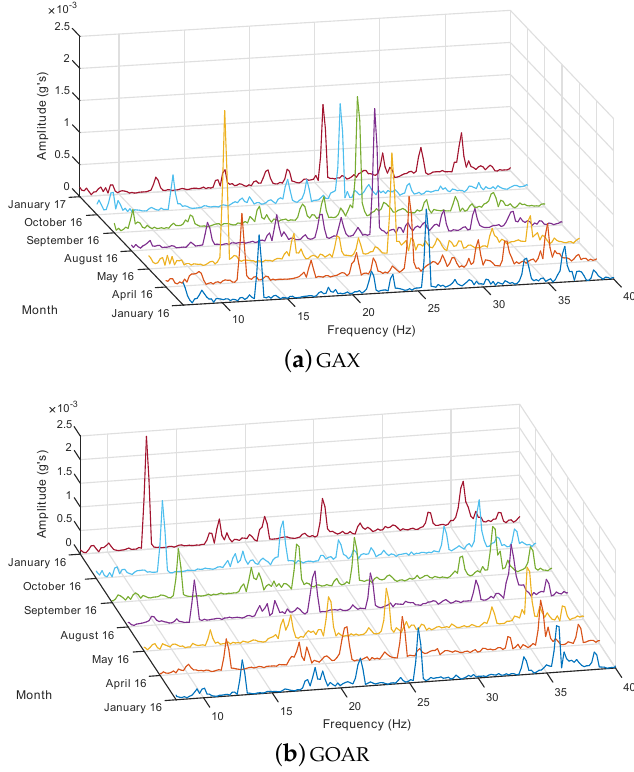
Figure 10. January 2016–January 2017. Evolution of shaft-frequencies at sub-synchronous